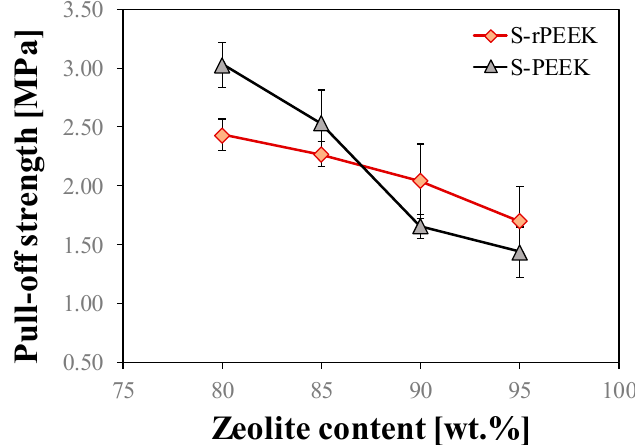
Figure 5. Comparison between pull-off adhesive strength of composite coating at varying filler content of S-PEEK and S-rPEEK.